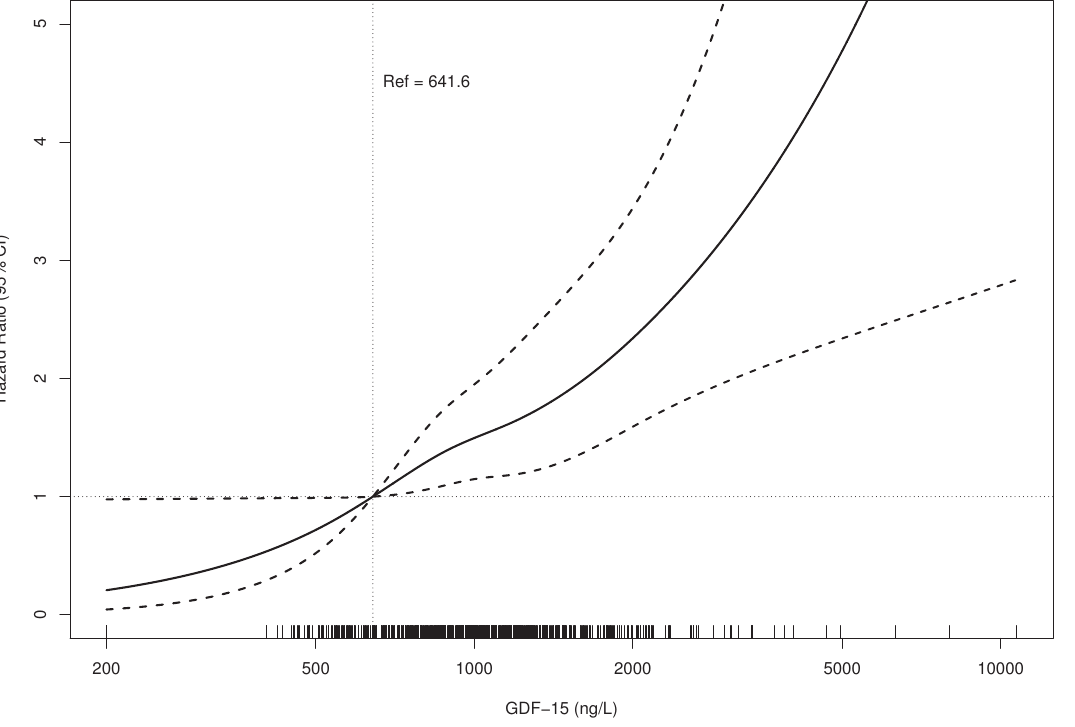
Figure 1. ConfirmationoftheyieldofWharton’sjelly-derivedmesenchymalstemcells(WJ-MSCs)underhigh-pressureconditions.( A )Observationofstar-shapedcellsby Figure 1. Relationship between GDF-15 Concentration and Mortality.(HR bold line, 95% CI dotted opticalmicroscopyonthe4th,9th,and9thdaysoftheinitialcultureofWJ-MSCs.TheWJ-MSCswereculturedundercontrol,5%hypoxia,or5%hypoxiawith2.0PSI lines).Adjusted for age, sex, BMI, smoking status, localization of OA, diabetes, maximum walking pressureconditions.Scalebar = 100 µ m.( B )CalculationoftheyieldofWJ-MSCsby9dayspost-WJ-MSCseeding. C:5%CO 2 ,37 ◦ Casacontrol,C + H:control + 5%O 2 hypoxia,C + H + P:control + 5%O 2 hypoxia + 2.0PSI,mean S.E.M.* p -value < 0.05. Sixbatchespergroupswereassignedandtested. distance, total cholesterol, and log-transformed concentrations of cystatin C, hs-CRP, hs-cTnI, ± and NT-proBNP (Model 3 from Cox proportional hazards analysis). BMI—body mass index; OA, osteoarthritis; hs-CRP—high-sensitive C-reactive protein; hs-cTnI—high-sensitive troponin I; NT-proBNP—N-terminal pro-B-type natriuretic peptide; GDF-15—growth di ff erentiation